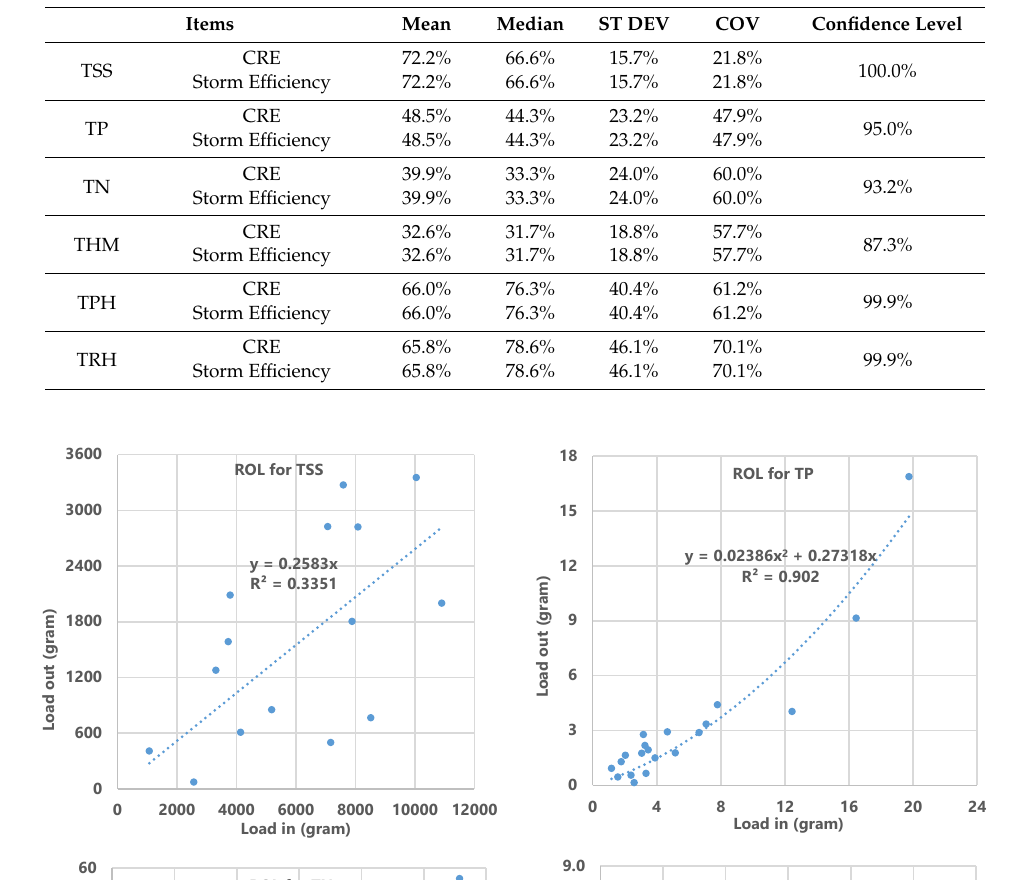
Table 6. Statistics for e ffi ciency performance metrics.